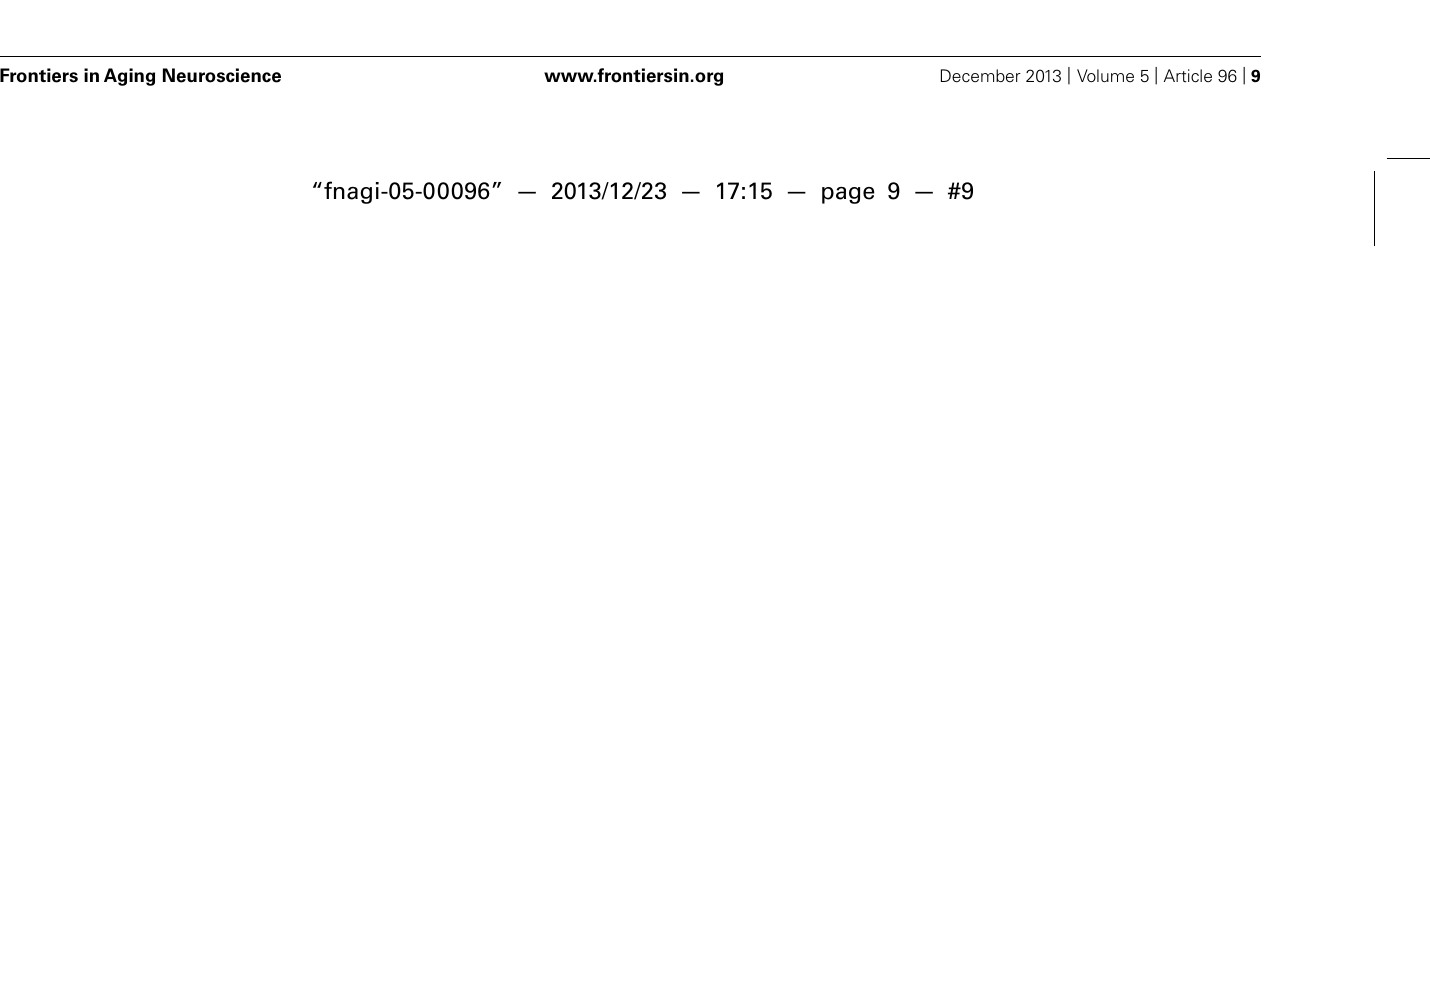
FIGURE 5 | Early chronic administration of RS 67333 reduces astrogliosis and microgliosis in 5XFAD mice. One-month-old 5XFAD females were treated according to protocol 1 (1 mg/kg RS 67333 twice a week for 3 months). Representative images of hippocampus sections from controls (vehicle) and treated mice show GFAP [ (A,B) in red and pseudo-colored in white, respectively], IBA1 [ (D) in red], thioflavin T [ (A,B,D) in green] and Hoechst staining [ (A,D) in blue]. Images in A are mosaics, 10 × objective; images in (B) are higher